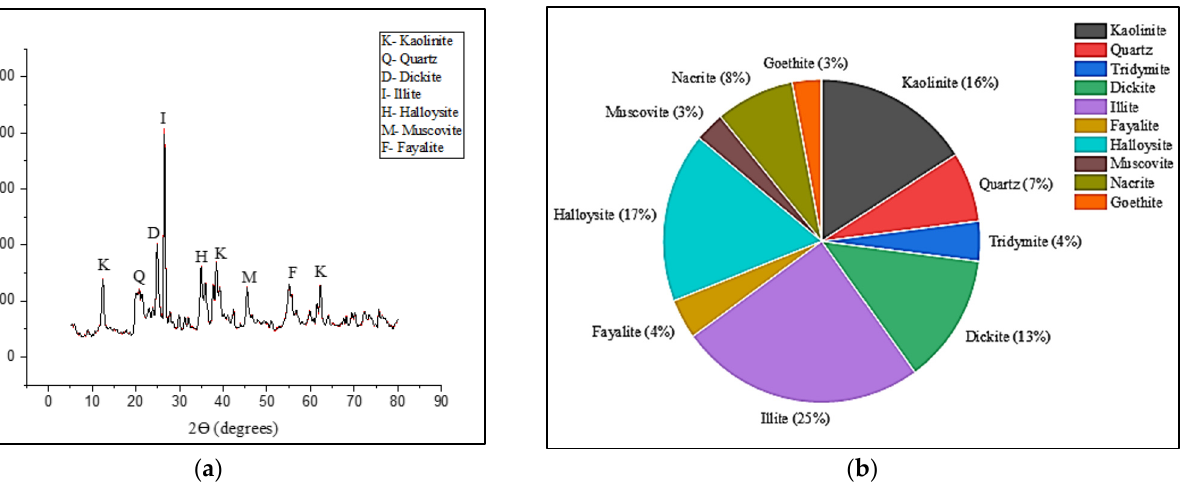
Figure 14. Characterization of minerals and compounds; ( a ) XRD analysis of Kumbashi sample, ( b ) quantification of compounds.